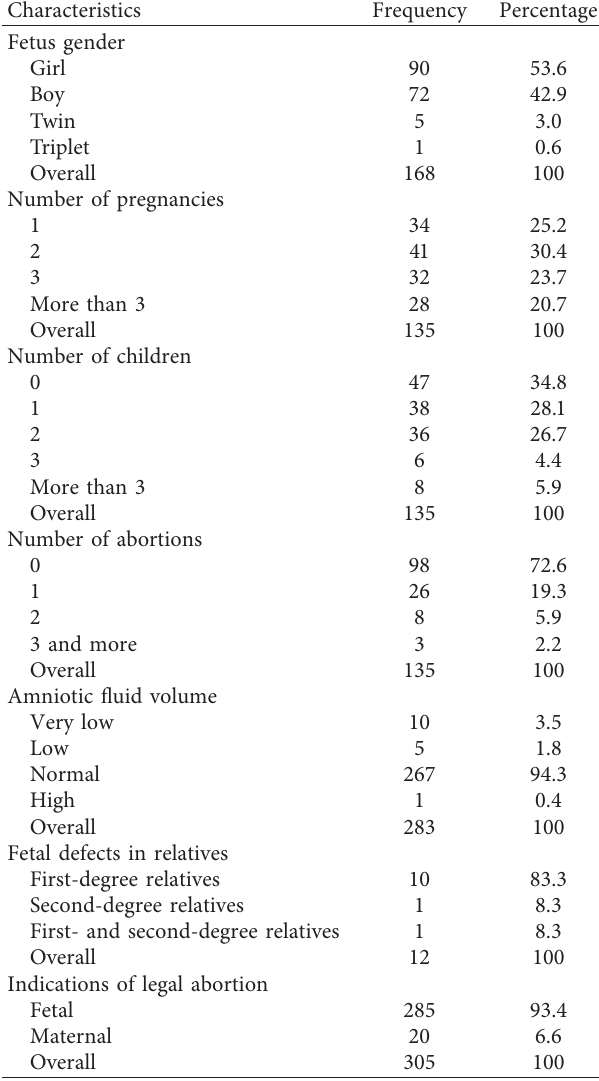
Table 2: Gynecological characteristics of the mothers.